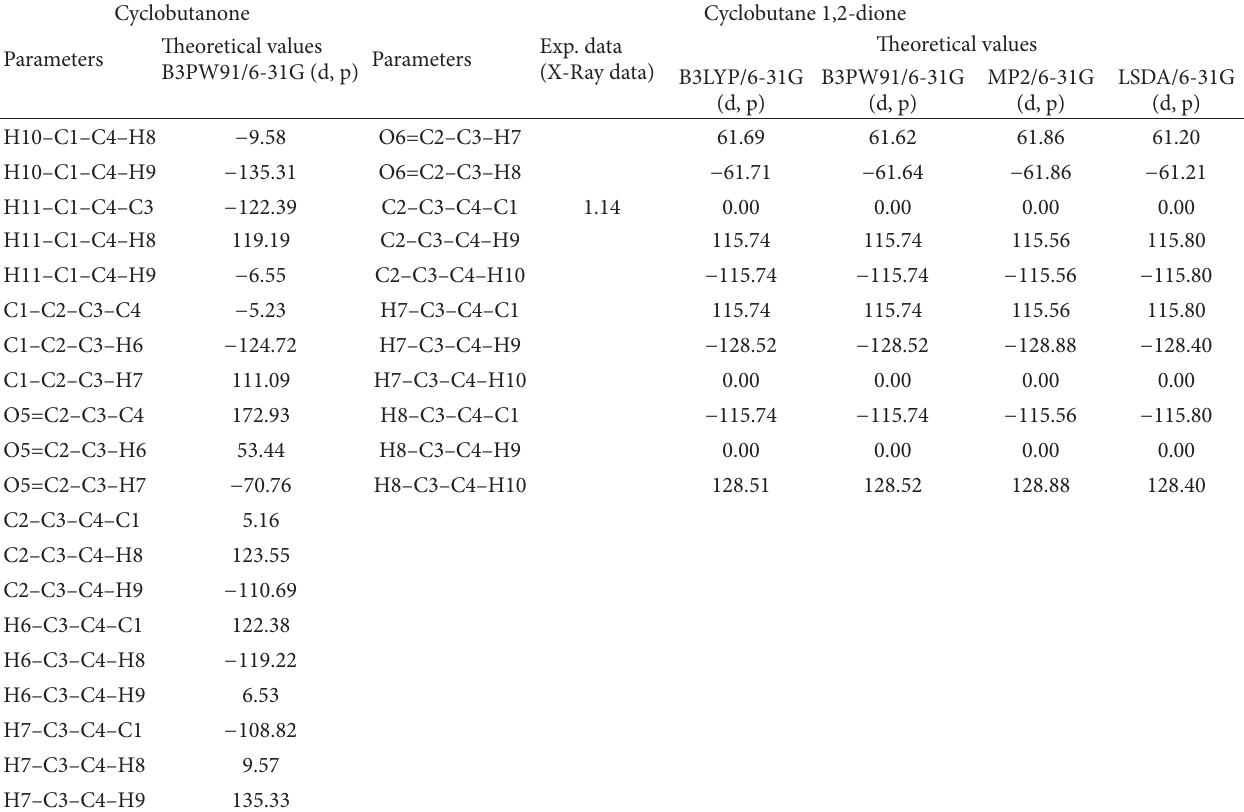
T 2: Symmetry in molecule at global minimum energy of 1,2-cyclobutanedione and cyclobutanone. Molecule Method Initial symmetry Higher order point symmetry Cyclobutanone B3PW91 C C 1 s Cyclobutane 1,2-dione B3PW91 C 2v